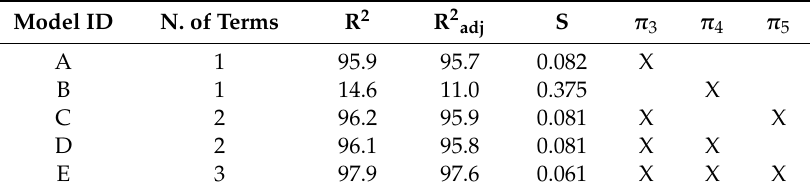
Table 8. Best subsets regression for 3 DC.